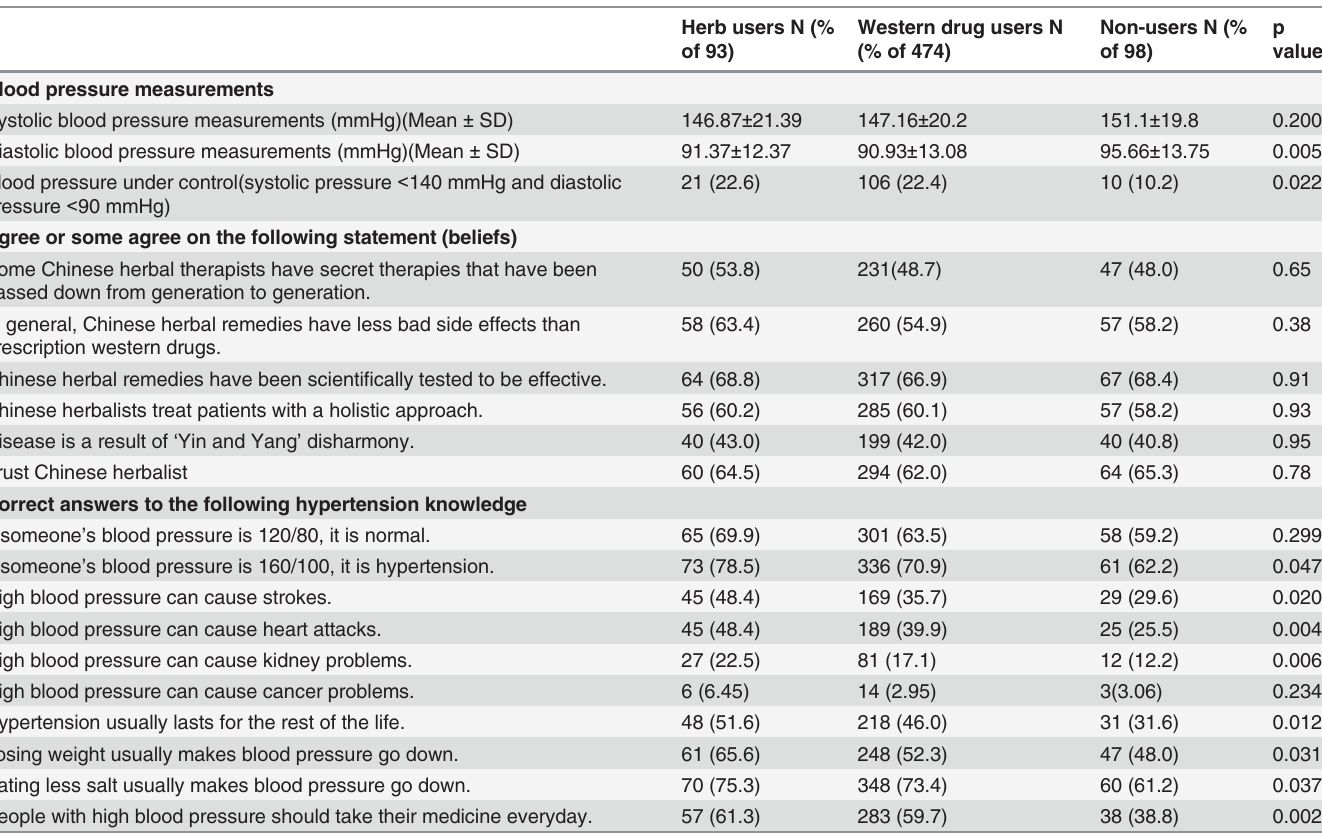
Table 3. Blood pressure under control, beliefs and hypertension knowledge among Chinese herbal therapy and western drug users * with diag- nosed